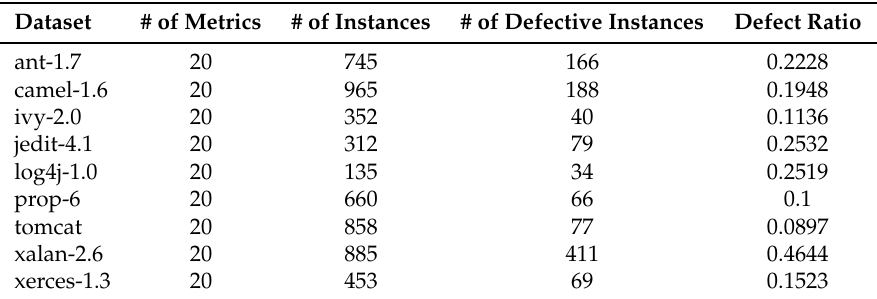
Table 12. Statistics of PROMISE datasets used in this